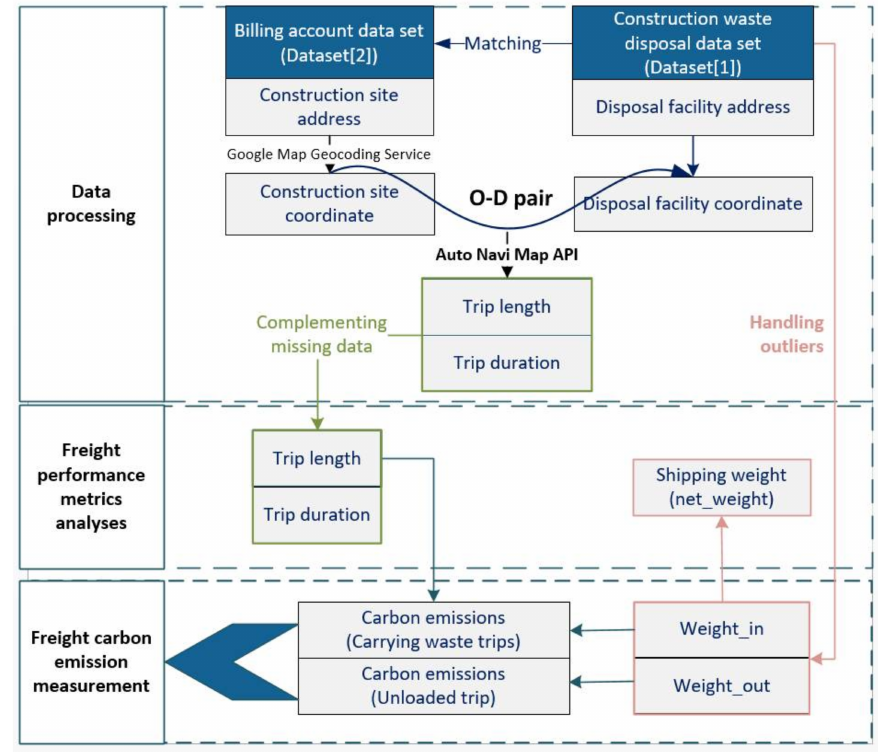
Figure 4. Research